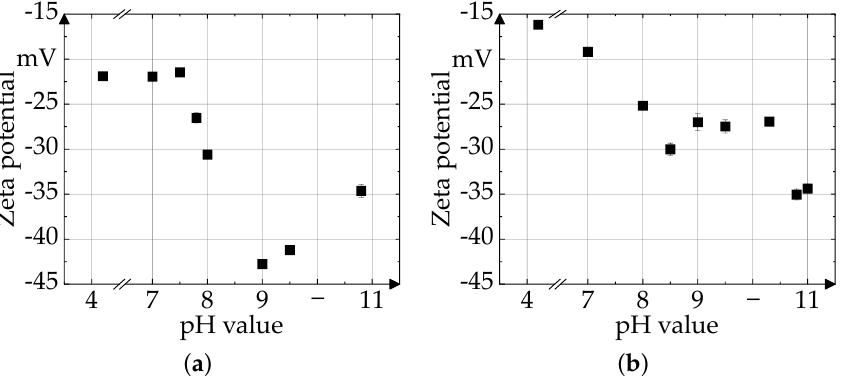
Figure 4. Zeta potential of graphite dispersions at various pH values for ( a ) a PVP content of 20 m% (see Table A5) and ( b ) a TX-100 content of 40 m% (see Table